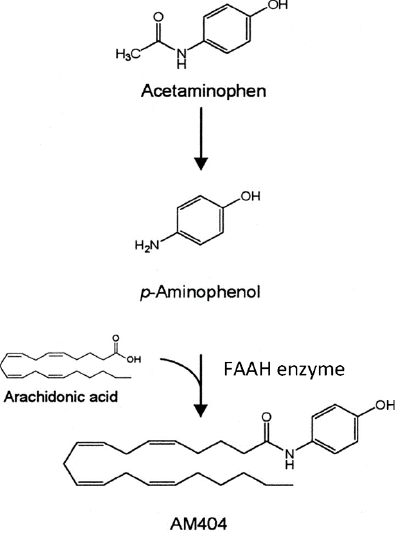
Figure 4. AM404 synthesis. Adapted from [6], under the terms of the Creative Commons CC-BY license.